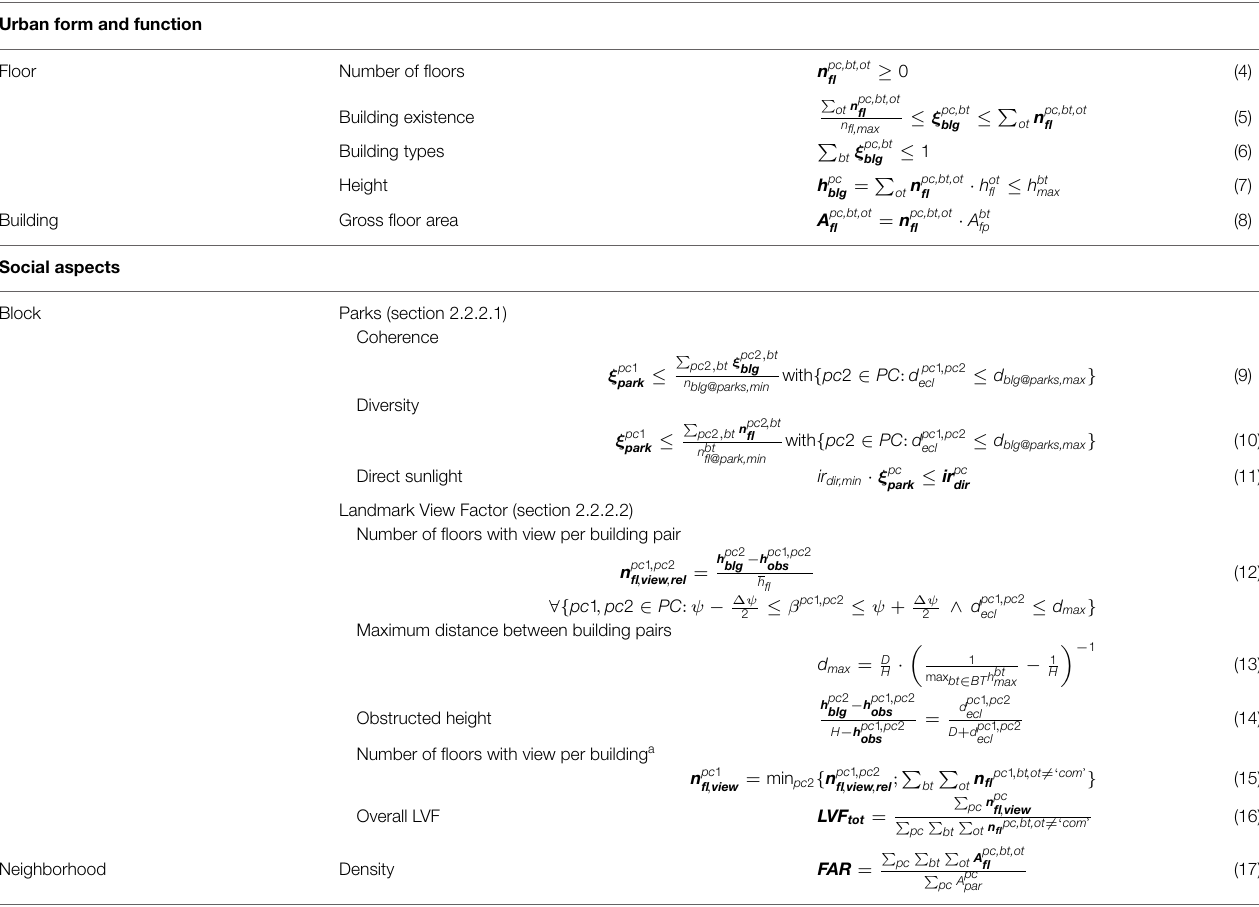
TABLE 1 | Model equations for urban form and function and social